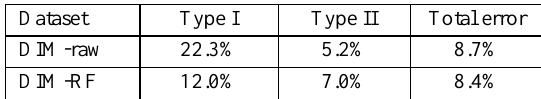
Table 1. Quantitative evaluation of the filtering